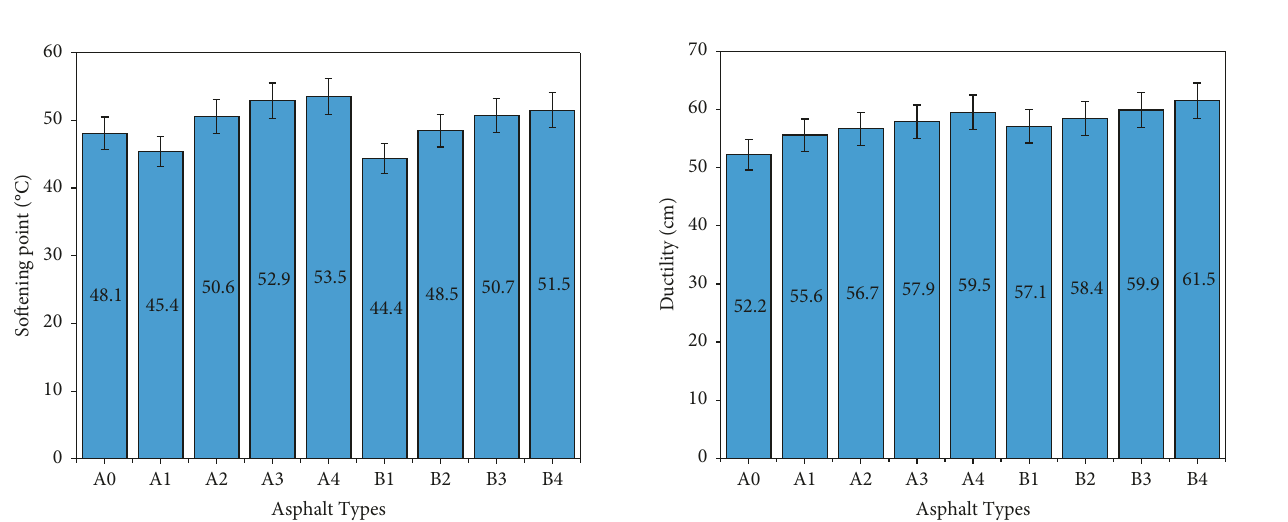
Figure 5: Effects of different GO dosages on the softening point of bio-asphalts.